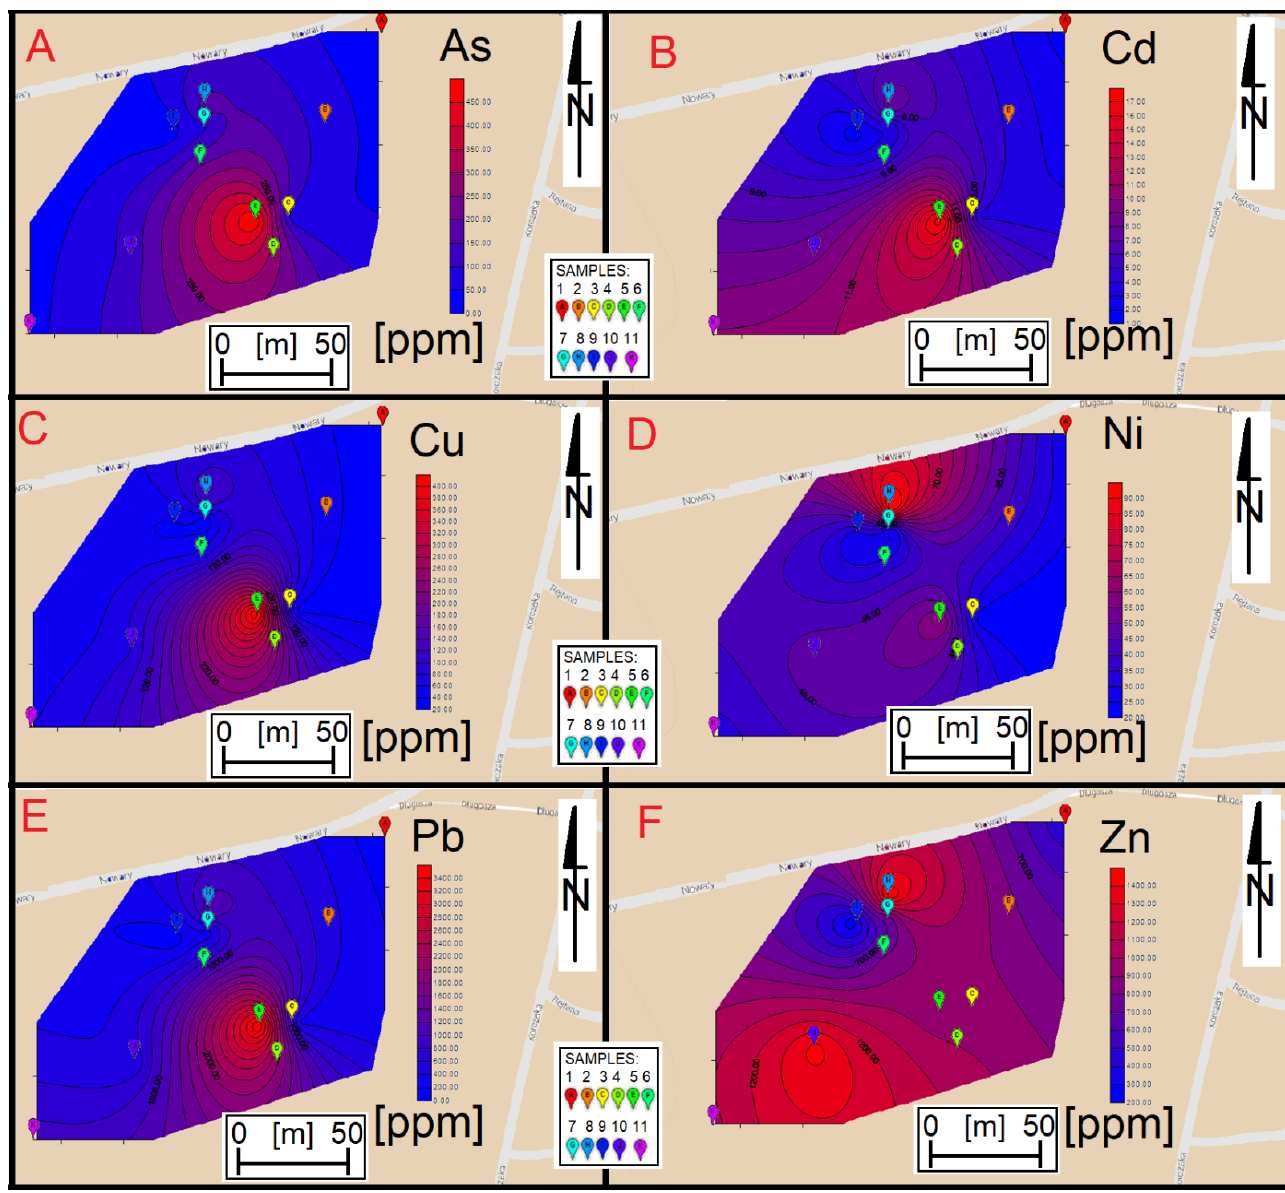
Figure 9. Maps showing the distribution of heavy metal elements in the heap area Maps were made respectively for: arsenic ( A ), cadmium ( B ), copper ( C ), nickel ( D ), lead ( E ) and zinc ( F ).